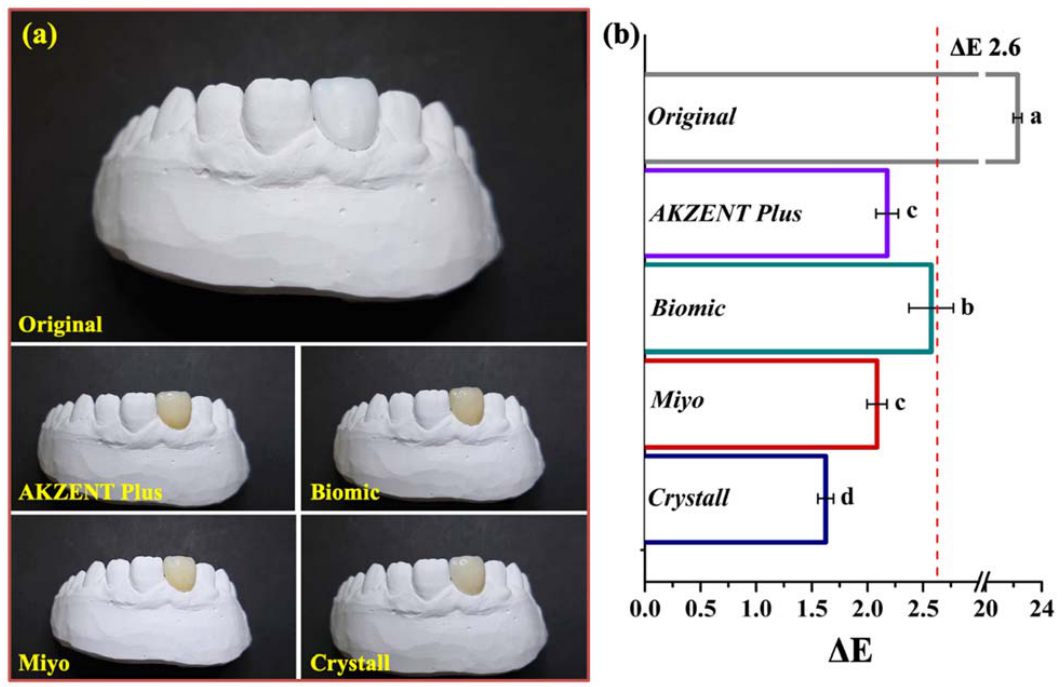
Figure 10. Applied assessment of the zirconia samples. ( a ) Appearance of the zirconia crowns after staining. ( b ) Δ E of zirconia crowns after staining. Means with different letters were significantly different ( p < 0.05, mean ± SD, n = 5).